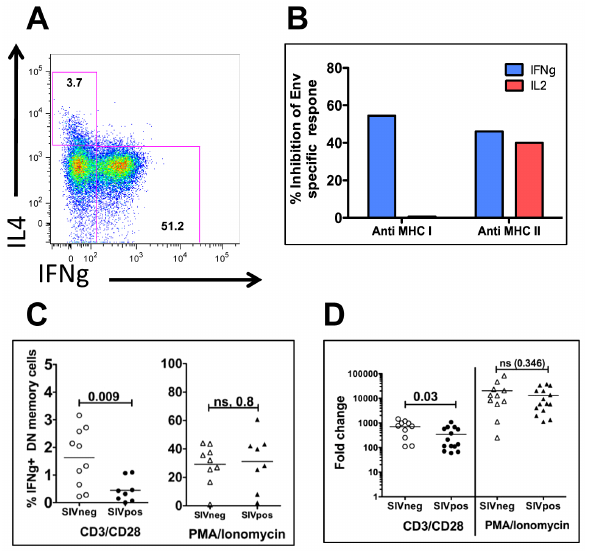
Figure 7. Cytokine expression (flow cytometric and quantita- tive real-time PCR) and MHC restricted response of DN T cells. A) Representative flow cytometry plot of IFN c protein expression (x- axis) and IL4 protein expression (y-axis) indicating that different DN subpopulations generally express either IFN c or IL4 (not both). B) Quantification of the percent inhibition of SIV-Env peptide specific responses within DN T cells in the presence of MHC I (left side) or MHC II (right side) specific antibodies. Intracellular cytokine staining identifies IFN c (blue) or IL2 (red) expressed by DN T cells within PBMC of a SIV infected mangabey. There was minimal inhibition of IL2 expression in